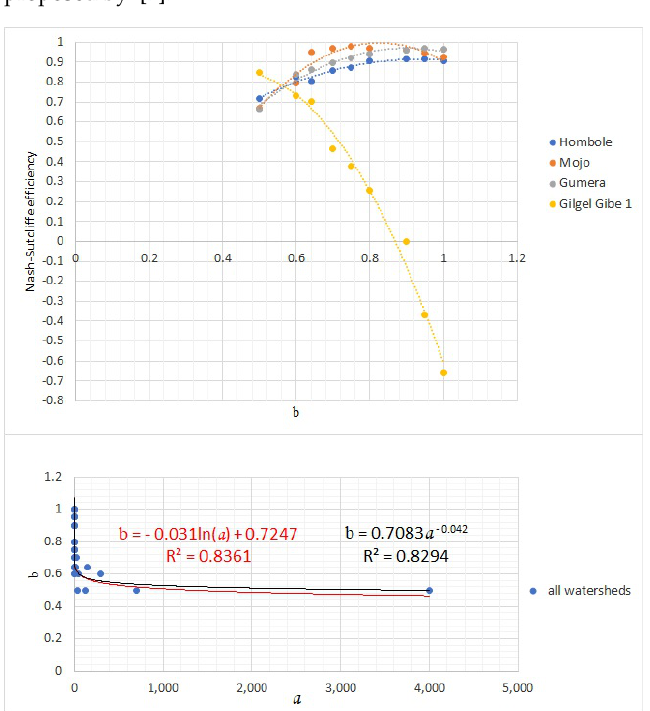
Figure 22. The relationship between exponent b versus the Nash–Sutcliffe efficiency and the coeffi- cient a versus the exponent b when the topographic factor is calculated using the equation that was proposed by